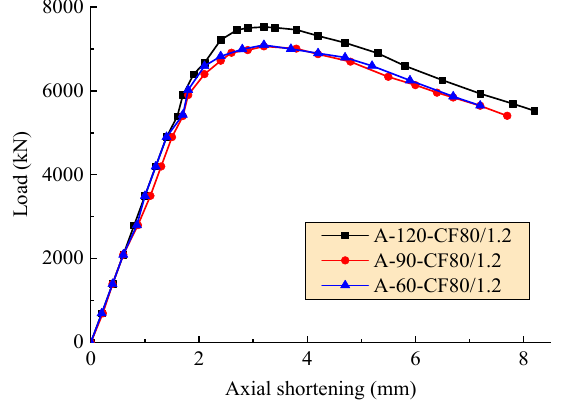
Figure 6. Axial load-deformation curves with varying hole spacing.